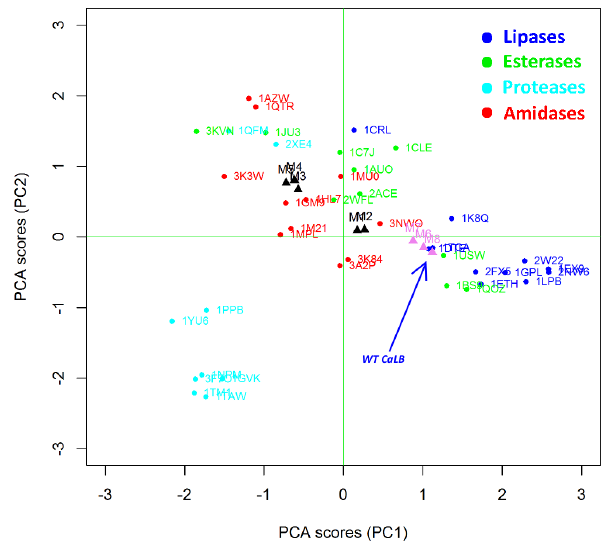
Figure 4. Projection of CaLB mutants in the BioGPS-UPCA model (global score). Improved mutants are highlighted as black triangles whereas poor mutants are in pink. WT CaLB (1TCA) is indicated by the blue arrow. The different classes of Ser hydrolases are reported in different colors, as also described in Figure 3.